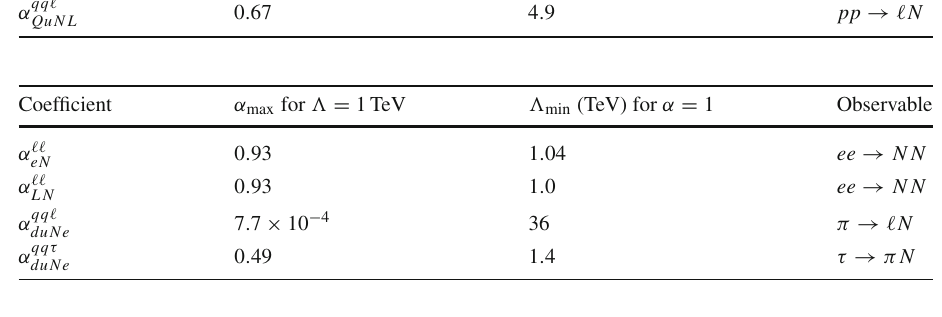
Table 11 Summary of limits on LRRL operators and observables they result from, assuming m N = 0 .